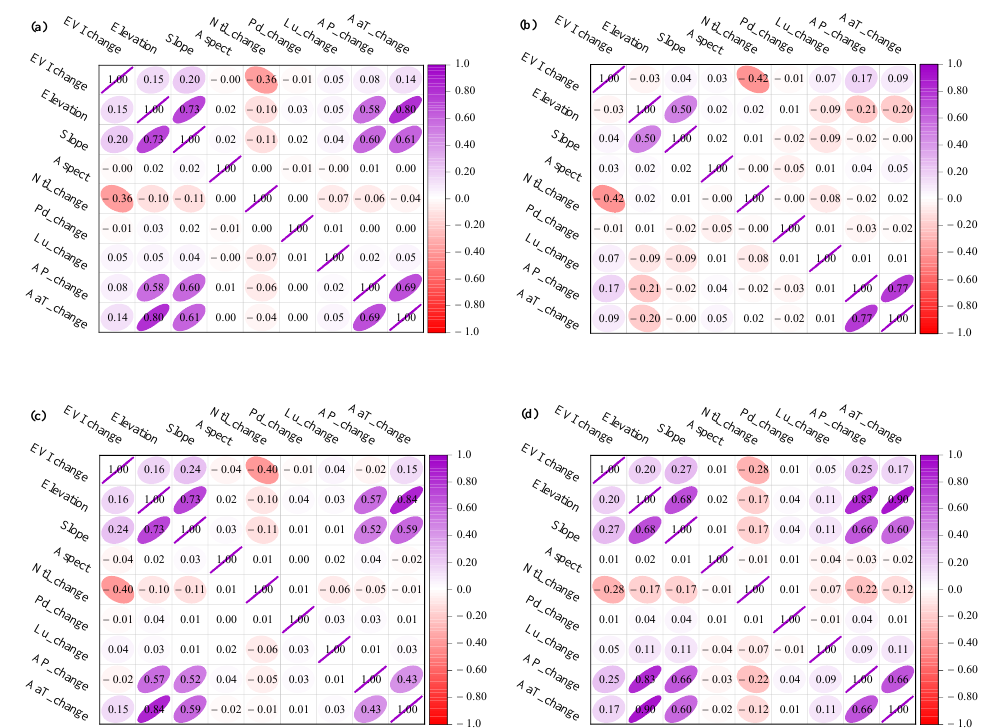
Figure 13. Pearson correlations of EVI variation and its potential drivers in ( a ) Anhui Province and ( b ) Northern, ( c ) Central and ( d ) Southern Anhui. Note: AaT_change = annual average temperature change; AP_change = annual precipitation change; Lu_change = Land use change; Ntl_change = nighttime light change.